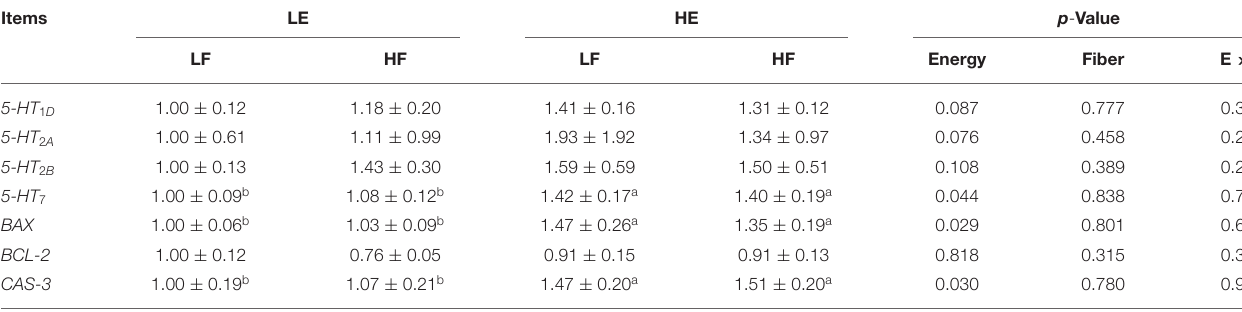
TABLE 4 | Effects of energy and fiber levels on relative mRNA expression in mammary gland. Items LE HE p - Value LF HF LF HF Energy Fiber E ×